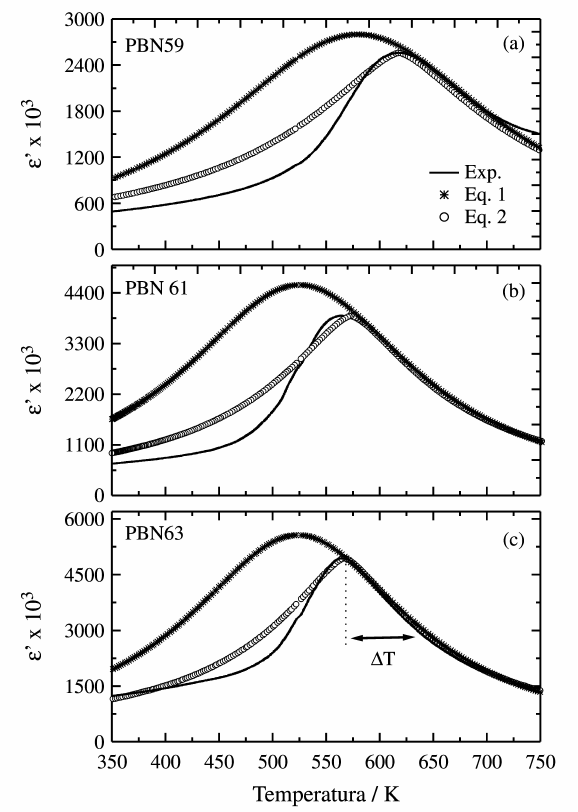
Figura 4. Constante dielétrica em função da temperatura à freqüência de 10 kHz. (a) Pb 0,59 Ba 0,41 Nb 2 O 6 , (b) Pb 0,61 Ba 0,39 Nb 2 O 6 e (c) Pb 0,63 Ba 0,37 Nb 2 O 6 . Nessas ilustrações estão apresentadas as curvas de ε ’ vs T geradas através dos parâmetros de ajuste das Eqs. 1 e 2. Tabela 1. Parâmetros experimentais e de ajuste (utilizando as Eqs. 1 e 2) obtidos das curvas de ε ’ vs T das amostras de